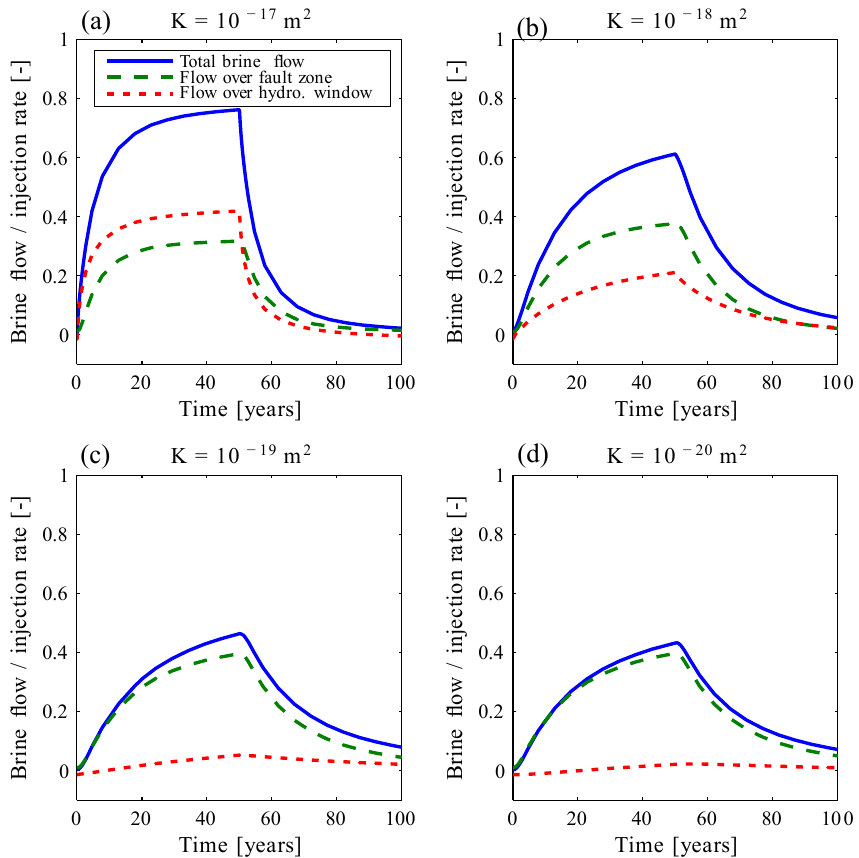
Figure 12. Scenario study 3: variable Upper Buntsandstein barrier permeability. Brine flow is normalized by the brine injection rate into the shallow aquifers for different permeabilities of the Upper Buntsandstein barrier. The scenario in panel (b) with a permeability of 1 × 10 − 18 m 2 corresponds to the reference case.